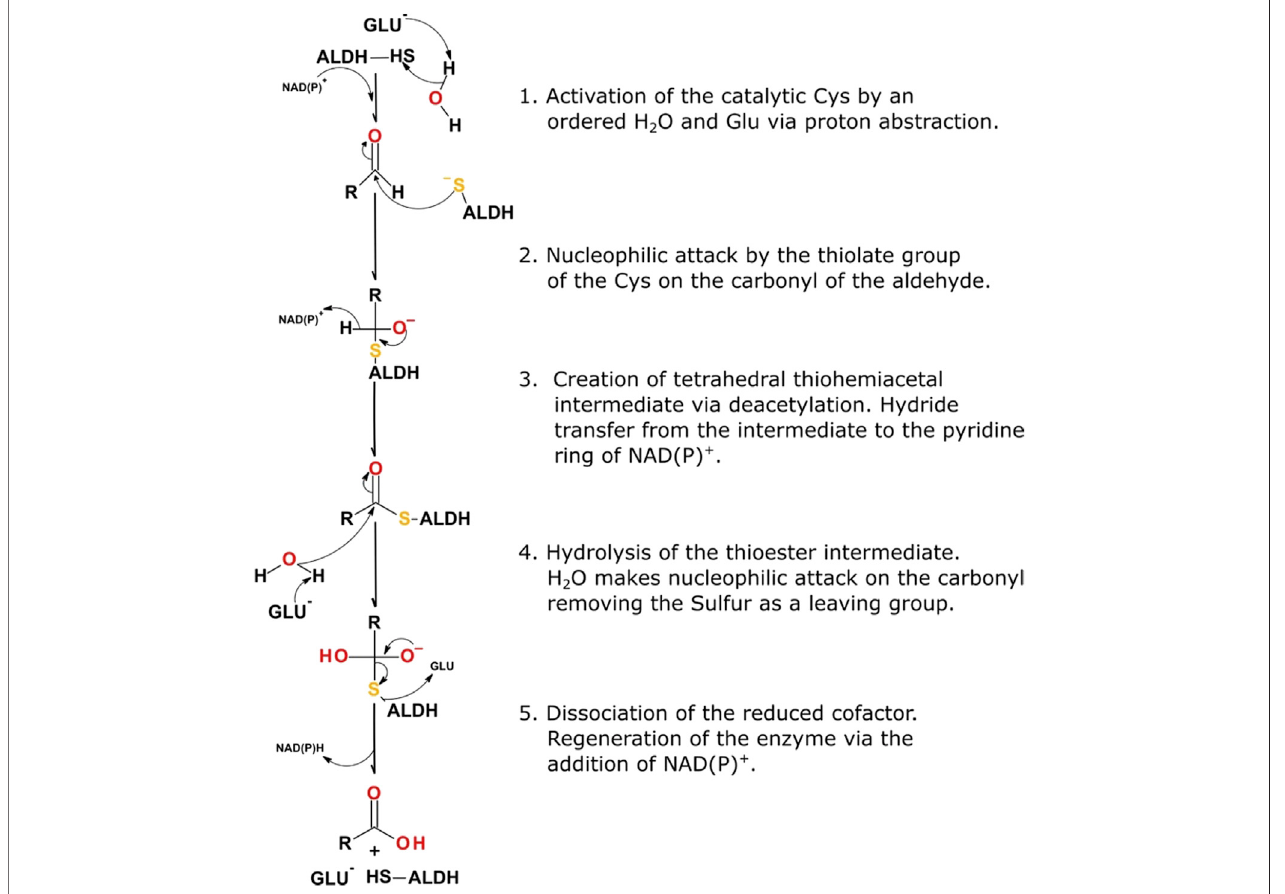
FIGURE 3 | ALDH reaction mechanism highlighting the fi ve essential steps in the catalytic